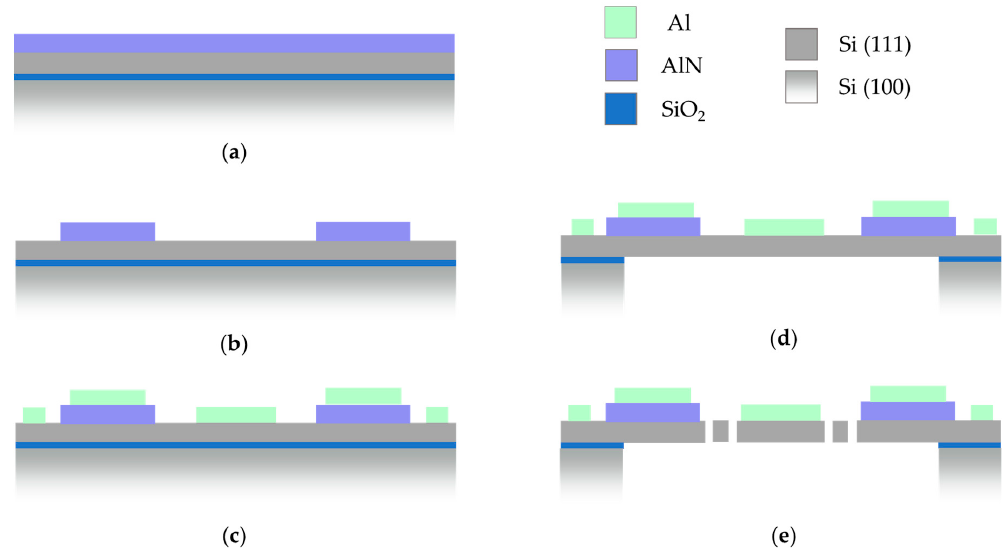
Figure 7. The fabrication process flow: ( a ) AlN deposition; ( b ) AlN wet etching; ( c ) Al deposition and structuring; ( d ) Backside Si etching by deep reactive ion etching (DRIE); ( e ) Device Si